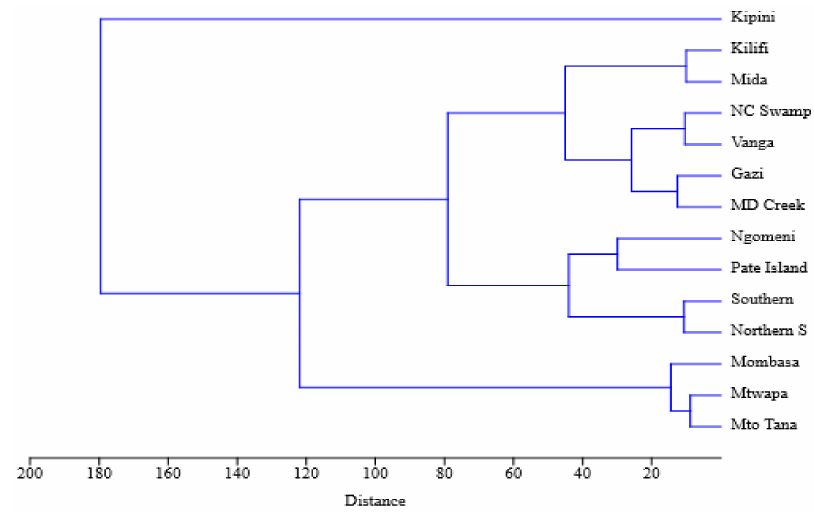
Figure 6. A dendrogram from the hierarchical cluster analysis across the 14 sampling sites along the coast of Kenya using unweighted paired group mean average and squared Euclidean pairwise